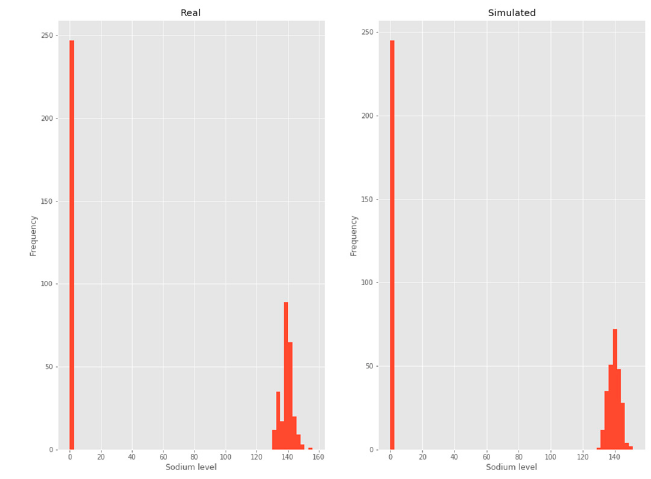
Figure 3. Sodium. Figure 3. Sodium.